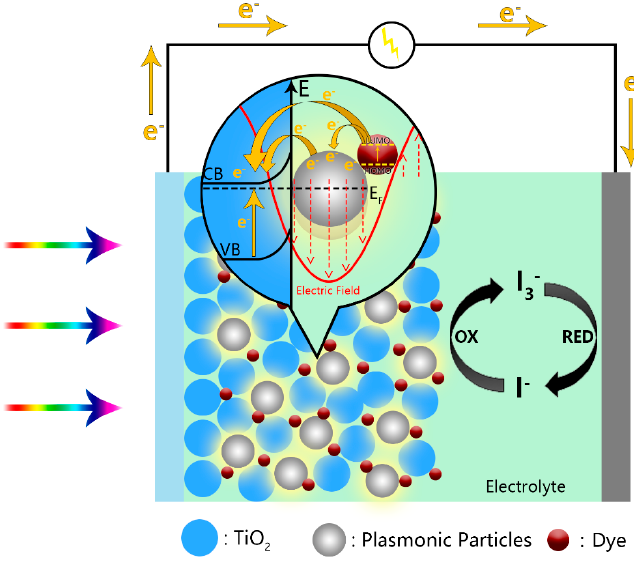
Figure 6. Illustration of plasmonic dye-sensitized solar cell.